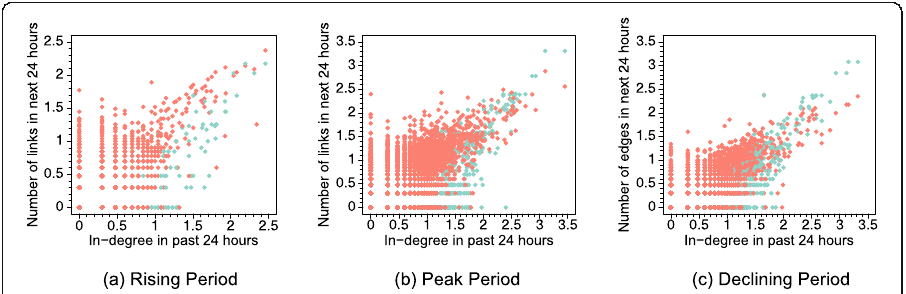
Fig. 7 Reticulation mechanisms of network growth among users (red points represent new link creation, and green points represent edge reinforcement). The x and y axes in these three figures are in logarithmic scale with a base of 10. The x-axis represents the in-degrees of online users in the past 24 h, and the y-axis represents the number of links created or strengthened in the next 24 h. Because the duration of each period is 72 h, two data sets are plotted in each figure (with the same color): in-degrees from hour 0 to 24 versus the number of link creations from hour 24 to 48; and in-degrees from hour 24 to 48 versus the number of link creations from hour 48 to 72. In addition, we measure two types of link creations: new links created (red dots); and link reinforcement (green